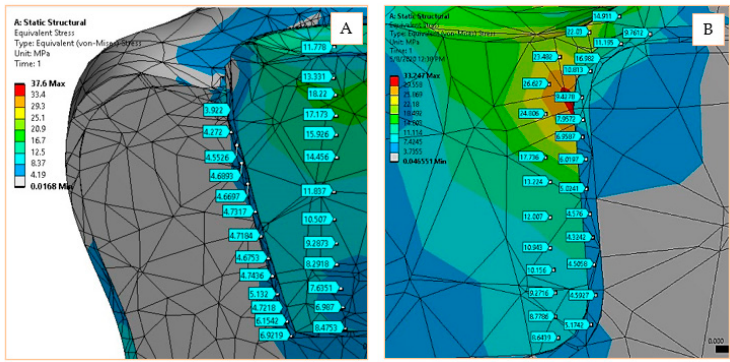
Figure 5. Stress sampling points of inlay model ( A ) and onlay model ( B ).